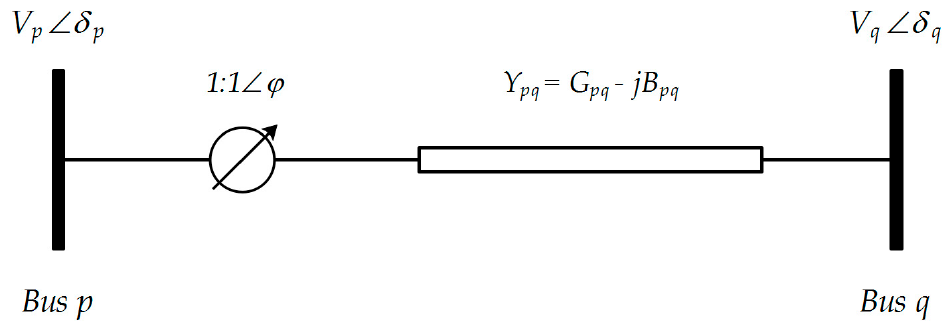
Figure 2. TCPS model connected between p th bus and q th bus.